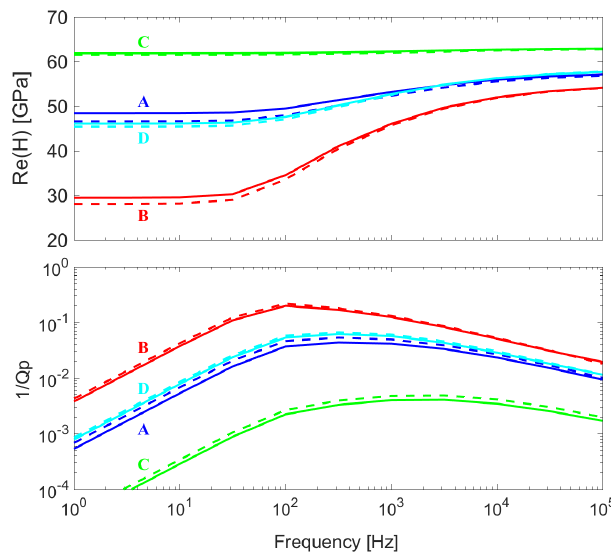
Figure 6. Real part of P-wave modulus ( H ) and attenuation for wave propagation normal to the fractures as a function of frequency. Solid lines correspond to fractures A, B, C and D with spatially variable aperture in the open regions (Fig. 5), while dashed lines correspond to fractures A, B, C and D with binary aperture (Fig.